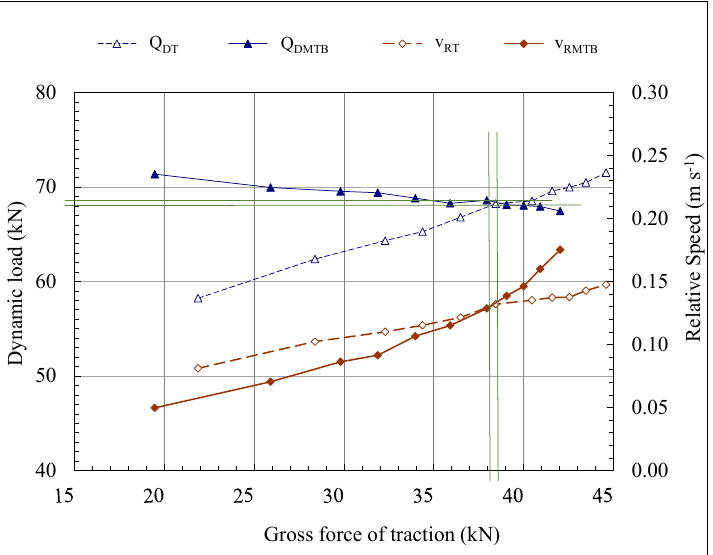
Figure 7. Trend of the tire dynamic loads, Q DT and Q DMTB, and of the relative speed, v RT and v RMBT , between tire surface and test track surface, respectively, observed for the MTB and the rear tires of the 2WD tractor.